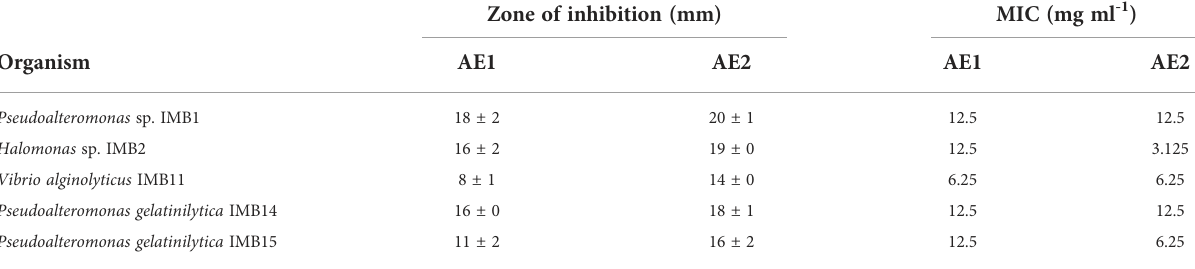
TABLE 2 Zone of inhibition and minimum inhibitory concentration (MIC) of extracts from Alcanivorax sp. AA8 against bio fi lm